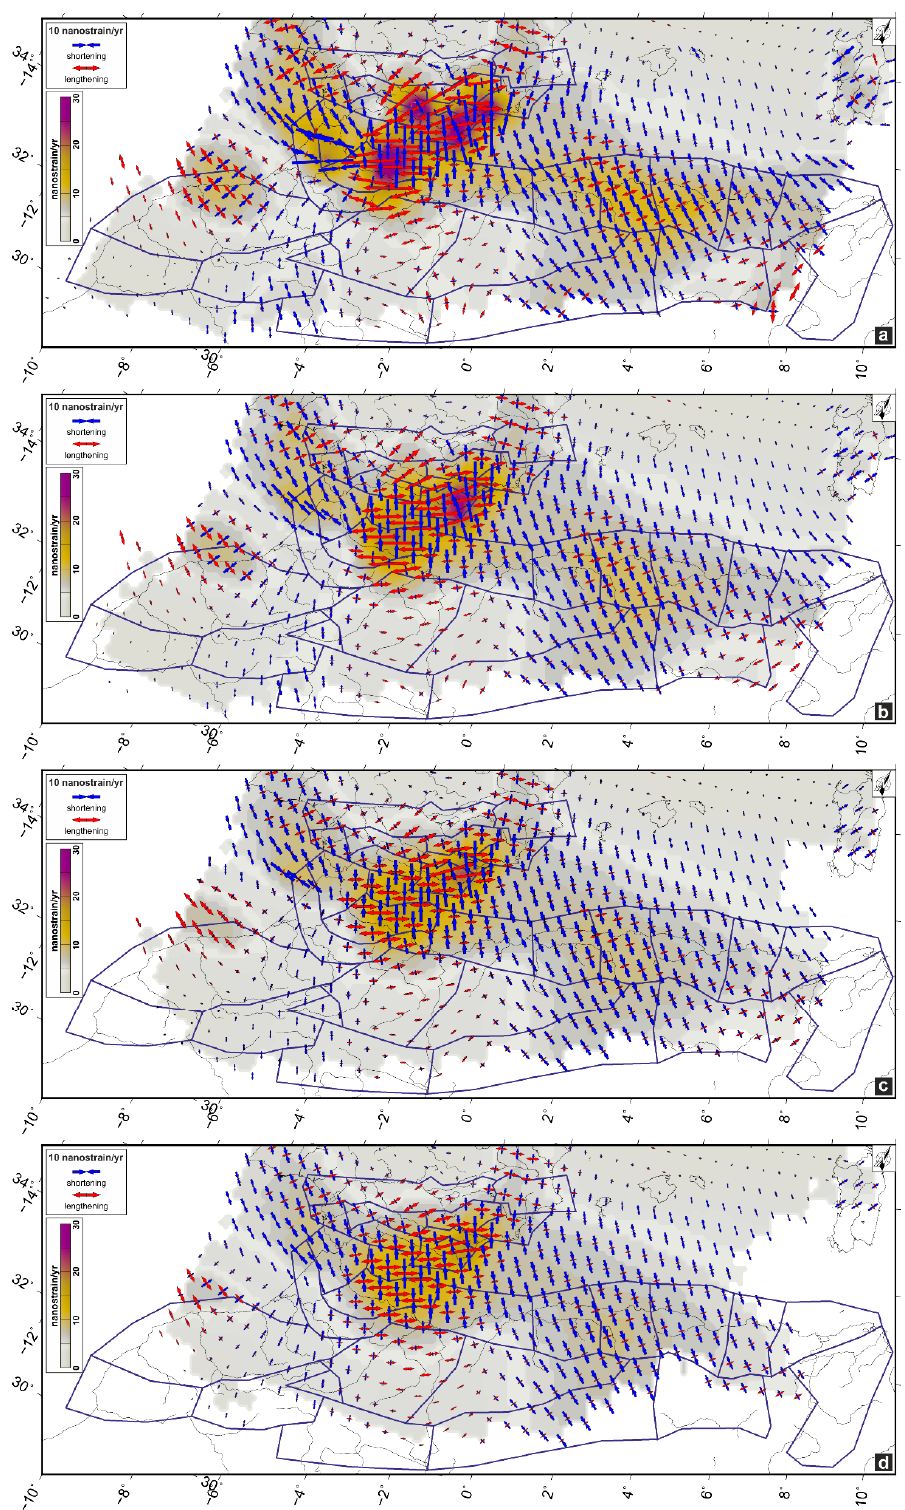
Figure A3. Estimated strain-rate field according to a Gaussian function for distance weighting of 12 (panel a), 18 (panel b), 24 (panel c), and 32 (panel d).